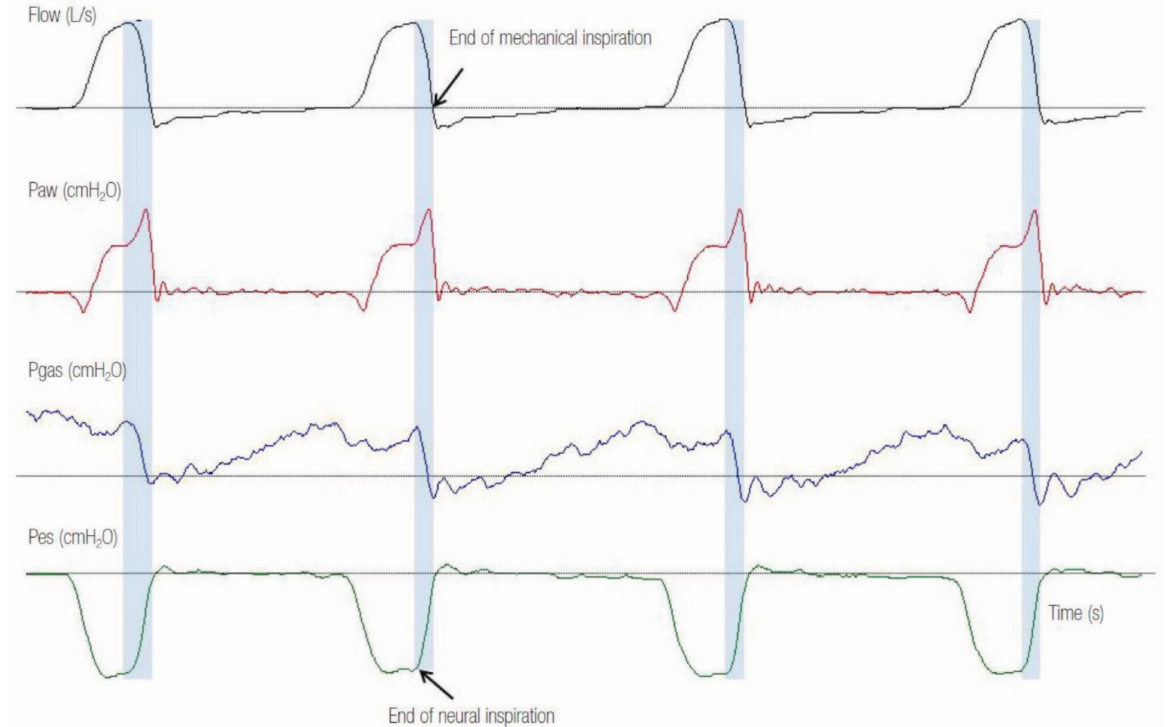
Figure 5. Example of delayed cycling in pressure support ventilation. There is a significant time delay (blue shaded area) between the end of neural inspiration, depicted by a rapid increase in esophageal pressure (Pes), and the end of mechanical inspiration, indicated by the termination of inspiratory flow (inspiratory flow equals zero). Notice the rapid upsurge of Paw near the end of mechanical inspiration, indicating inspiratory muscle relaxation